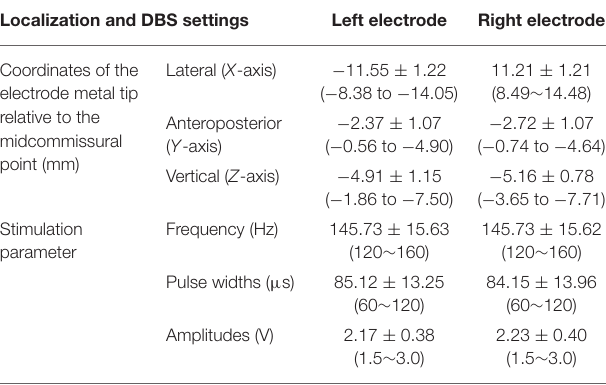
TABLE 2 | Position of the electrodes and DBS settings. Localization and DBS